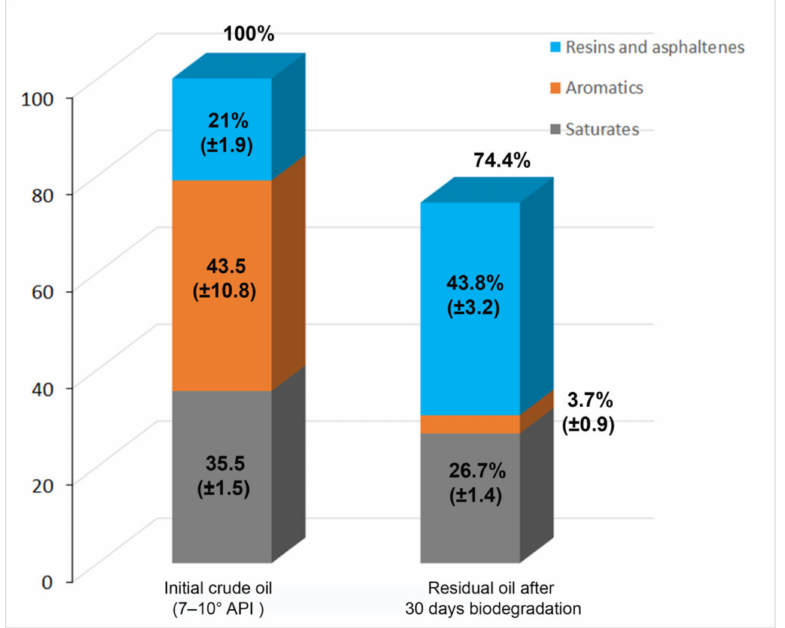
Figure 7. Hydrocarbon degradation after 30 days of growth by Alternaria sp. with extra-heavy crude oil (7–10 ◦ API) as the sole source of carbon initial and residual oil compositions. The number on the top of the columns represents the residual oil after biodegradation as a percentage of initial crude oil. The numbers on each column are the percentage of each fraction. The oils were fractionated by the modified SARA procedure to obtain the saturates, aromatics, and polar (resins and asphaltenes) fractions. The total petroleum hydrocarbons were determined by gas chromatography equipped with a flame ionization